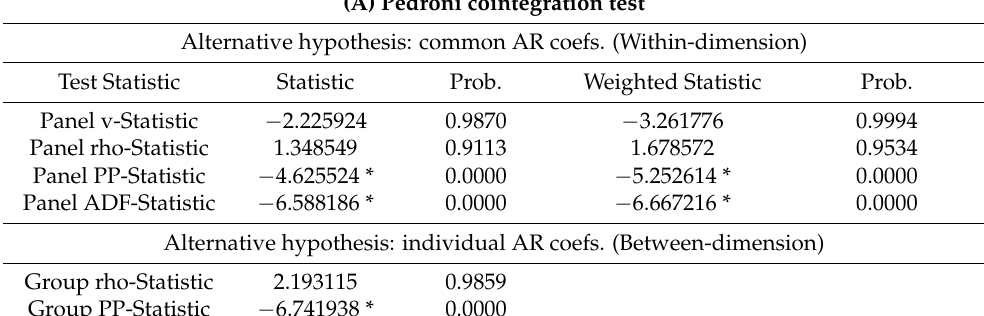
Table 6. Long-run cointegration outcomes (Pedroni, Kao, and Westerlund). (A) Pedroni cointegration test Alternative hypothesis: common AR coefs.